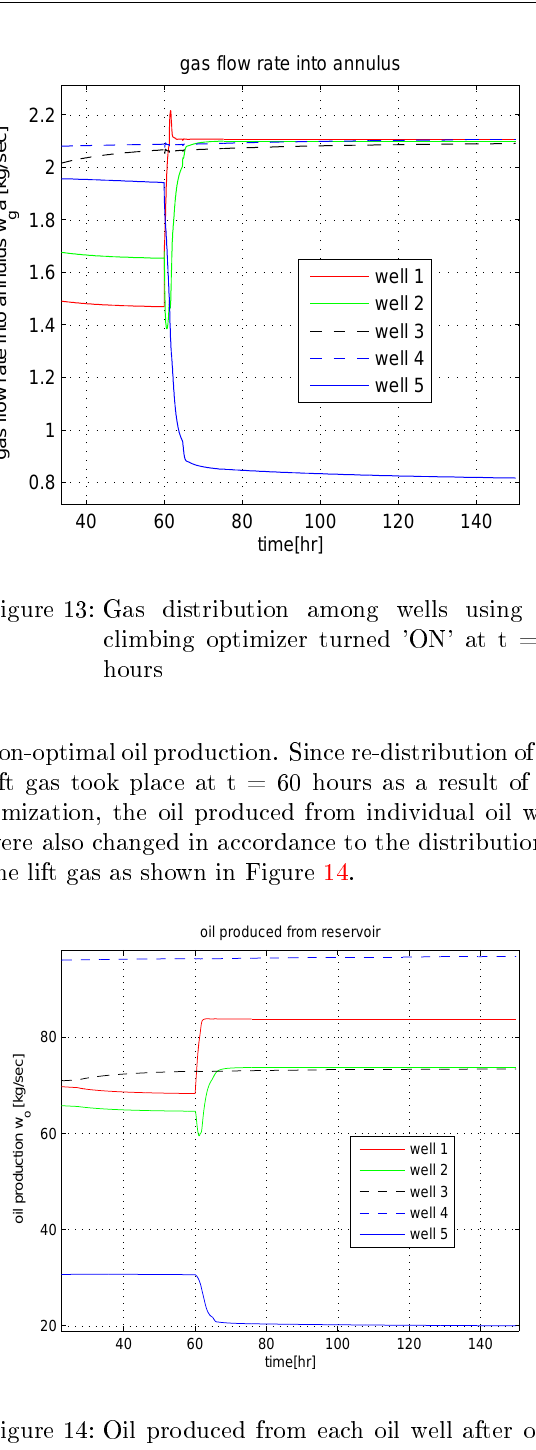
Figure 14: Oil produced from each oil well after opti- mization with hill climbing method Production of oil from oil well 1 and oil well 2